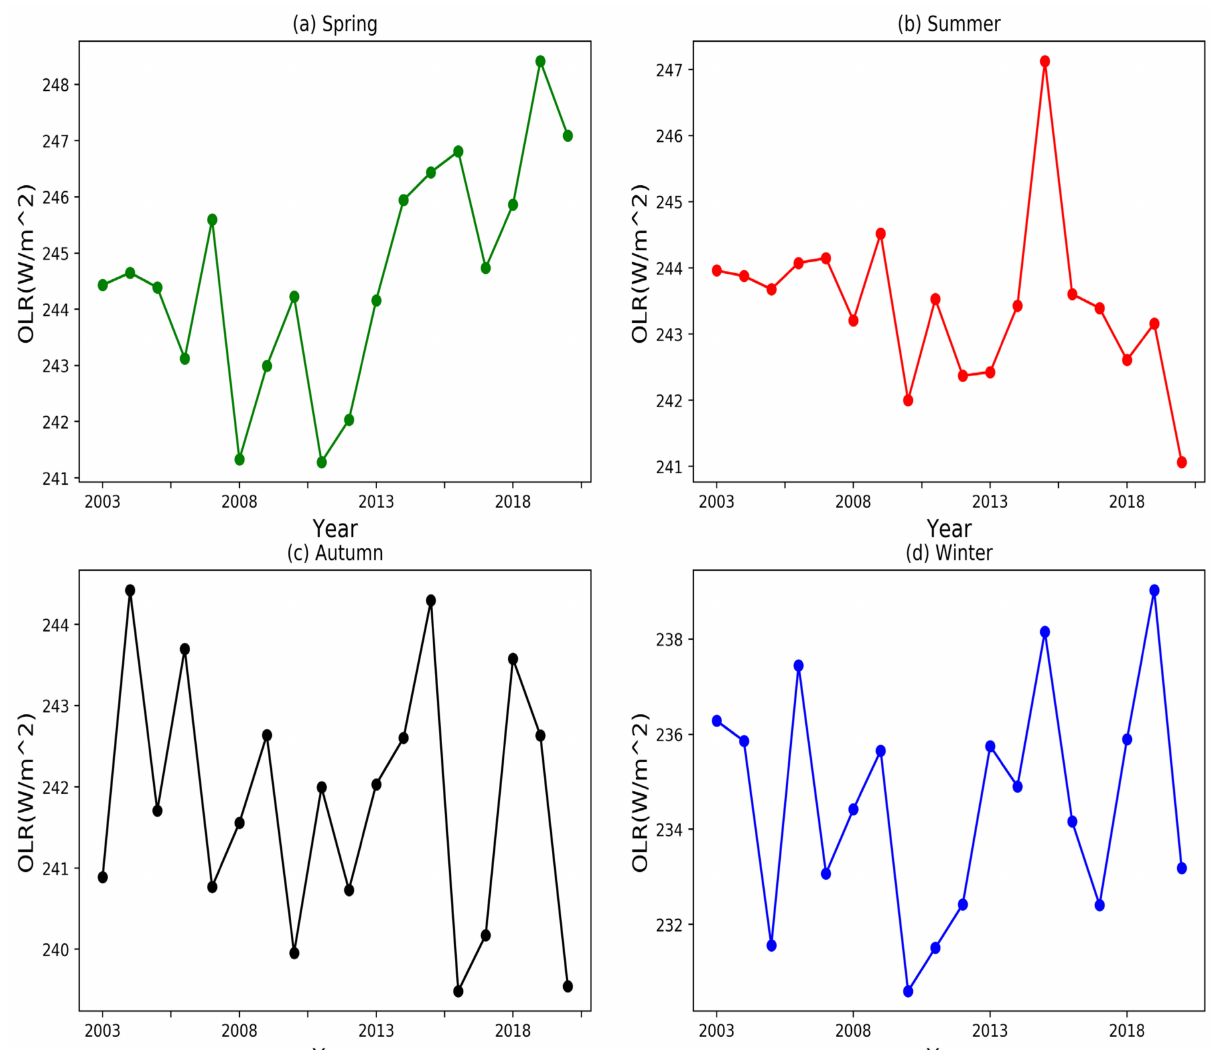
Figure 4. Inter-annual variability trend of OLR in Different seasons in China. ( a ) Spring. ( b ) Summer. ( c ) Autumn. ( d )